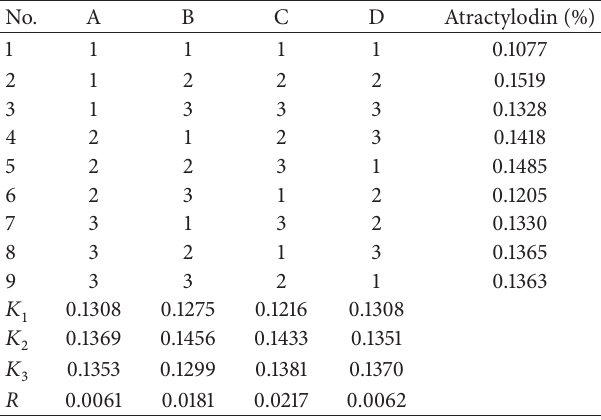
Table 2: Orthogonal experimental design test results of the ultrasonic-assisted extraction